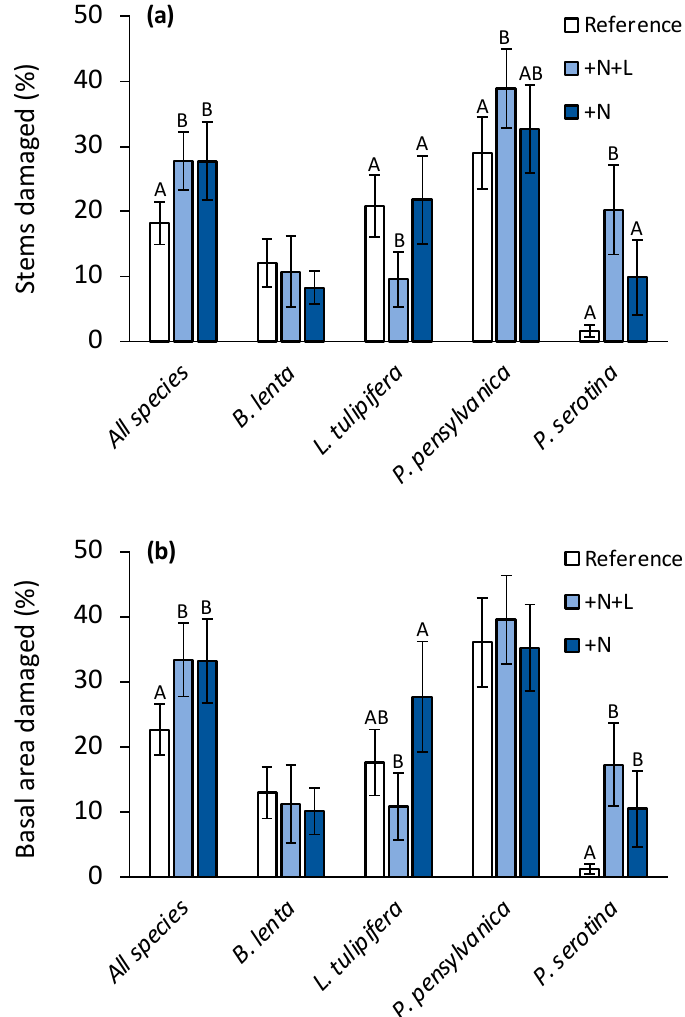
Figure 1. Tree damage from a windstorm across the reference, nitrogen fertilized (+N), and nitrogen and lime fertilized (+N+L) treatment areas in the Long-Term Soil Productivity Experiment (LTSP) Experiment: ( a ) Percentage of total basal area damaged across all tree species and within the four dominant tree species; ( b ) Percentage of total stems damaged across all tree species and within the four dominant tree species. Bars and error bars represent the empirical means and one standard error, respectively. Differences in capital letters within a species group denote significant differences ( p < 0.05) between treatments, determined by bootstrap hypothesis tests.